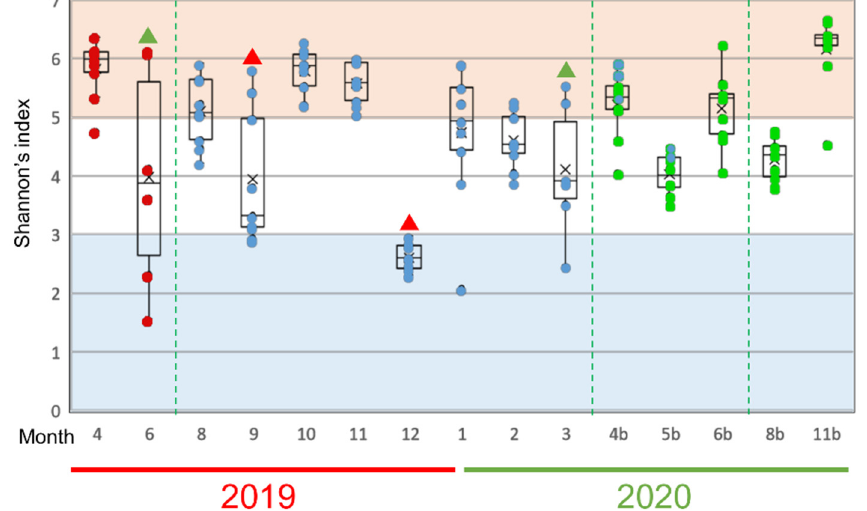
Figure 4. Alpha-diversity of epidermal mucus microflora of rainbow trout in a flow-through culture system. Shannon’s diversity index was calculated by rarefaction analysis, using 2.400 reads sampled randomly from each mucus sample. The results from 6–9 individual fish in each sampling month are represented by box plots; dots inside the boxes represent data from individuals, and the same color indicates fish reared from the eggs collected in the same fiscal year. Green triangles indicate months that the disturbance of the flora by specific bacteria was observed. Red triangles indicate the months that the occupation by specific bacteria was observed. The dotted green lines mark when fish were replaced on the farm.